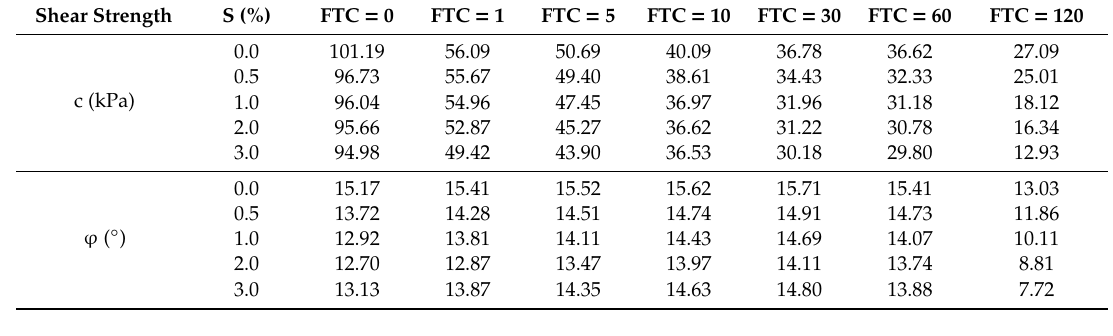
and FTC under different S.